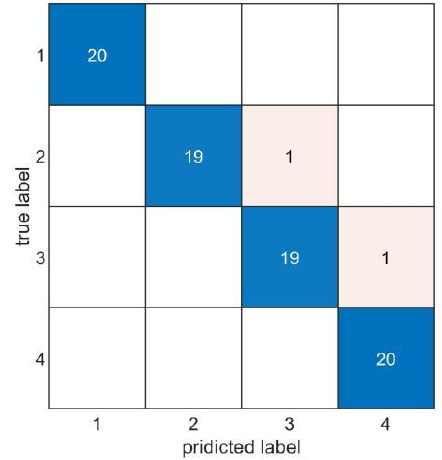
Figure 12. Confusion matrix of SSA-VMD-DPC.